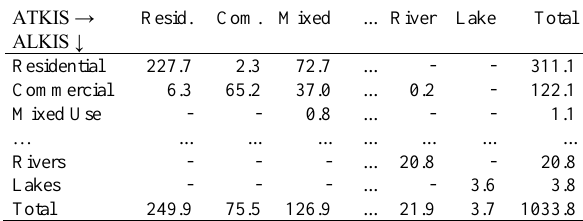
Table 1. Small part of the confusion matrix. The fields contain the summed up areas in hectare. Each line corresponds to a cadastral class, each row to a topographical